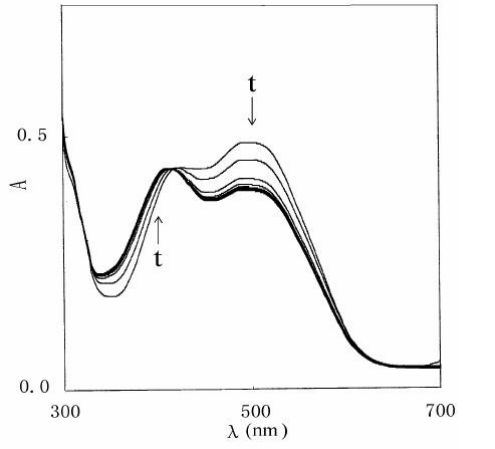
Fig. 3 Kinetic spectrum of the LiP catalyzed oxidation of PR in the presence of VA (10 mM). Conditions: [PR] = 40 μ M; [LiP] = 0.1 μ M; [H 2 O 2 ] = 60 μ M, the time interval for scanning was 5